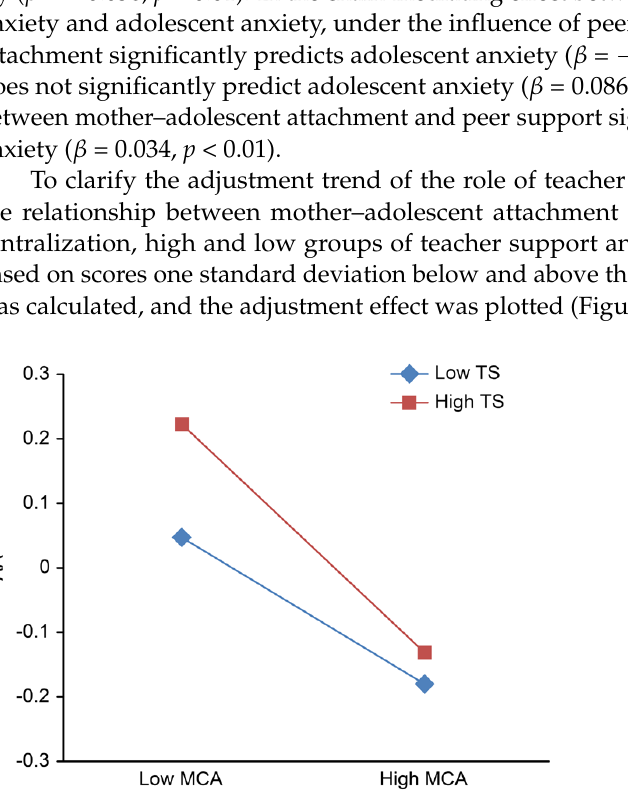
Figure 3. Teacher support adjustment chart b. MCA, mother-adolescent attachment; TS, teacher support; AA, adolescent anxiety. Figure 4. Peer support adjustment chart a. MCA, mother-adolescent attachment; TS, teacher sup- port; AA, adolescent anxiety.